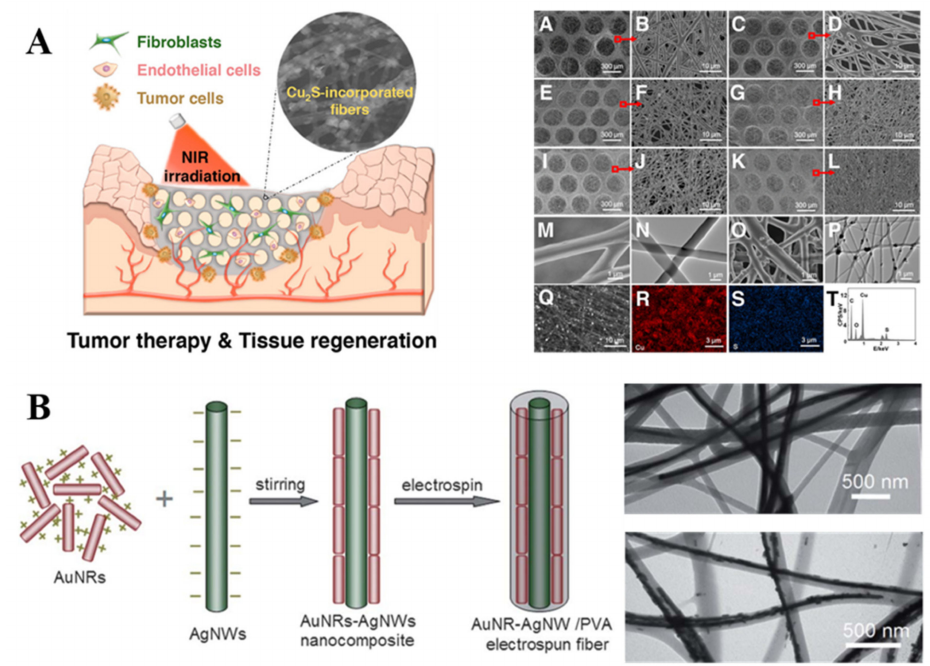
Figure 6. Preparation of nanocrystalline/electrospun composite fibers by direct mixing method.